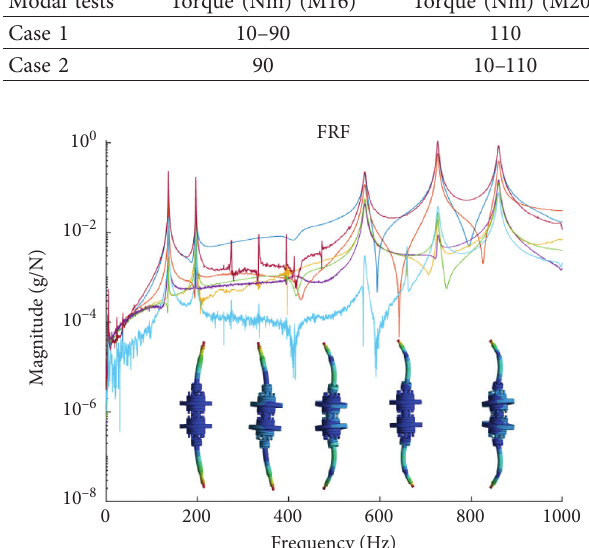
Figure 3: Frequency response function (FRF) obtained from seven accelerometers.